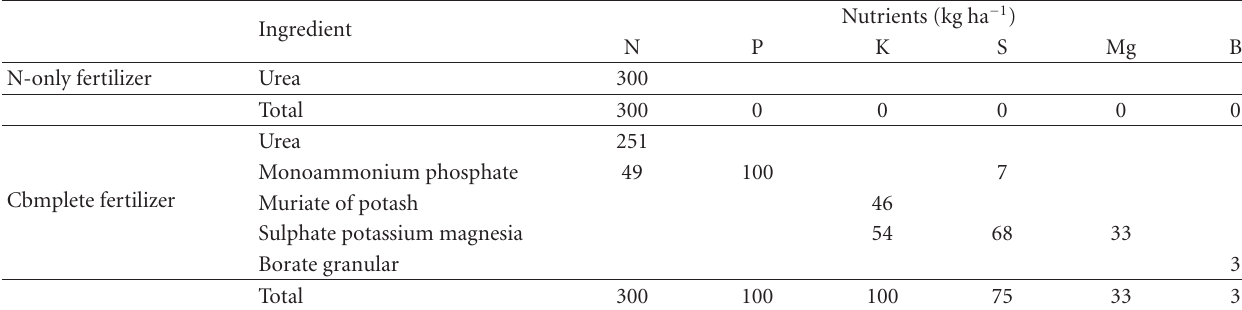
Table 2: Fertilizer formulations for N-only and complete